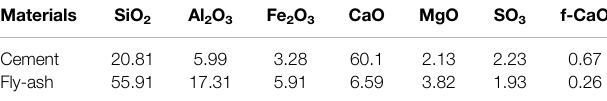
TABLE 3 | Test results of the amount of oxides in cement and fl y ash (%).